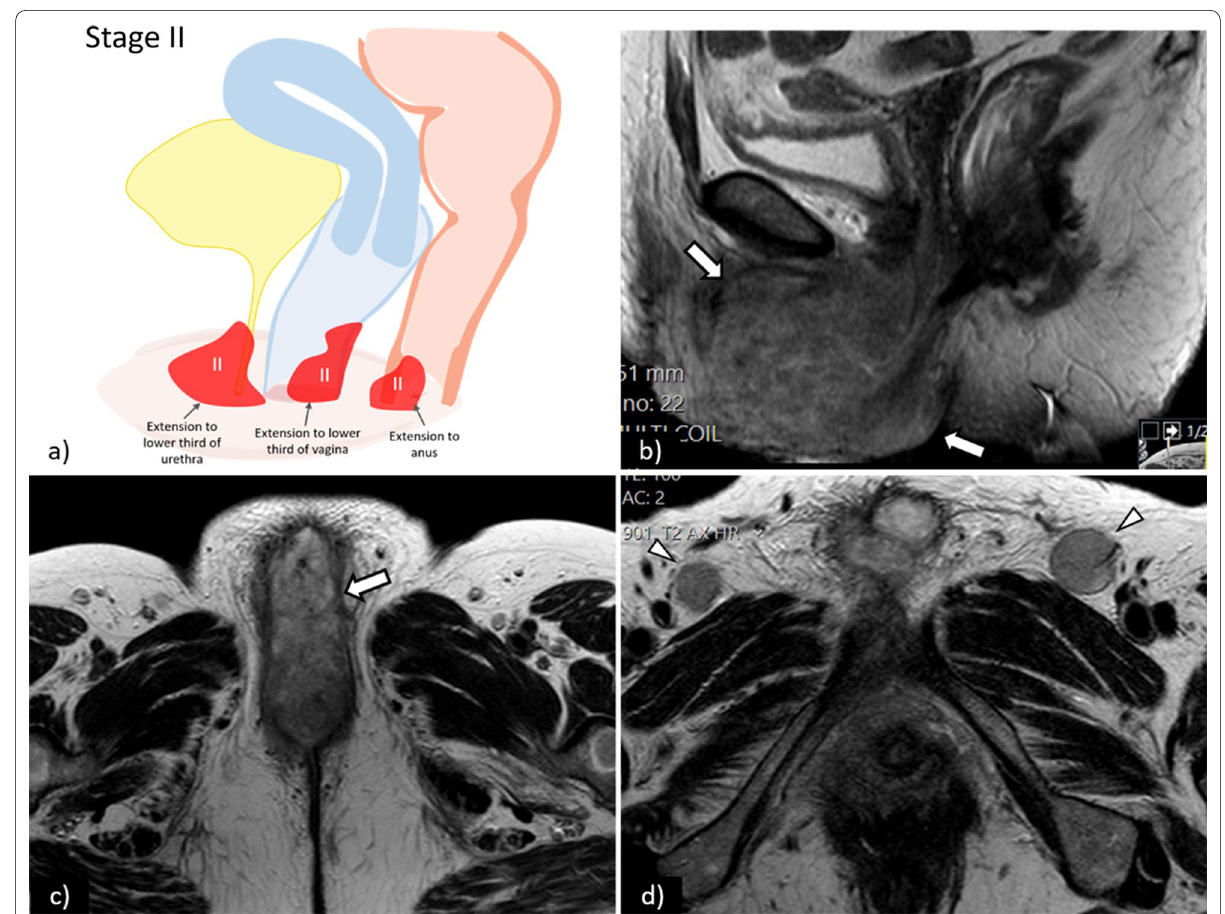
Fig. 4 a Schematic illustration of FIGO stage II. Sagittal ( b ) and axial ( c ) T2WI of the pelvis show a large tumour (arrows) with invasion of the lower third of the urethra—FIGO II. Axial T2WI of the groins ( d ) shows bilateral enlarged inguinofemoral lymph (arrowheads) proved to be reactive on